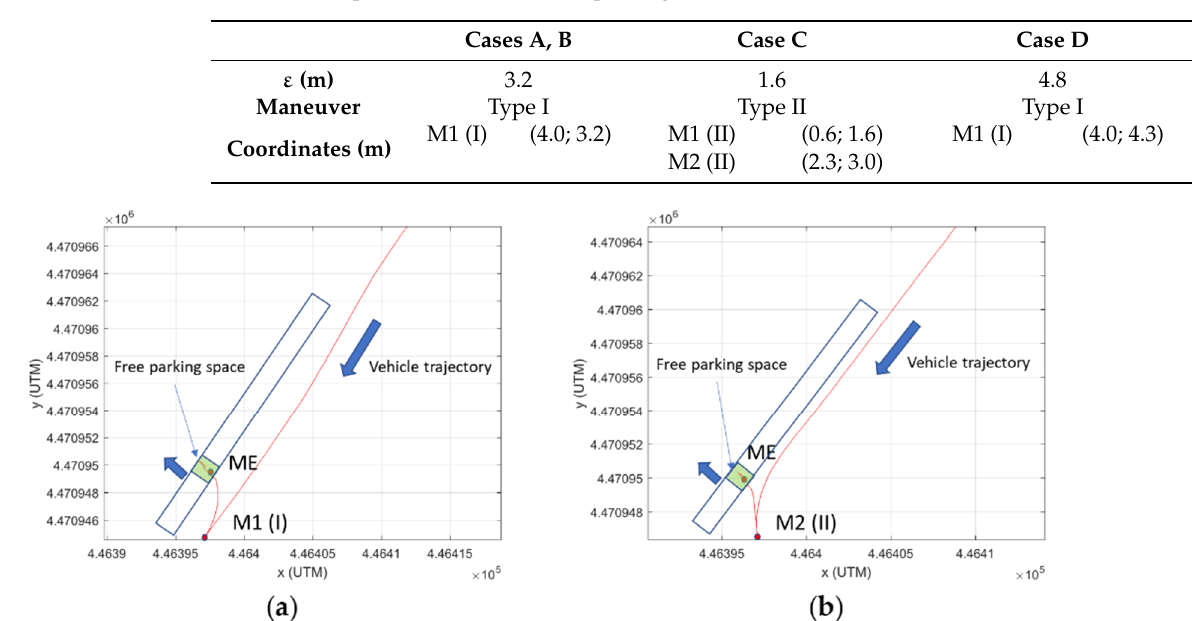
Table 3. Main point coordinates of the parking maneuver.